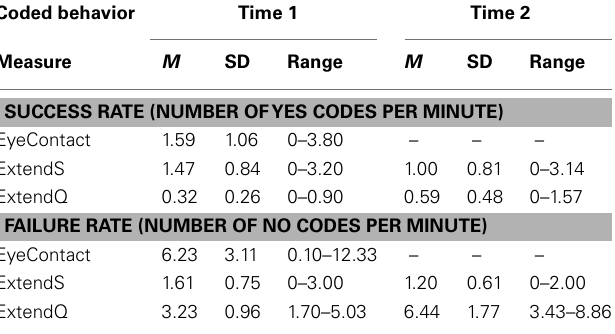
Table 3 | Bivariate correlations of non-verbal intellectual ability with